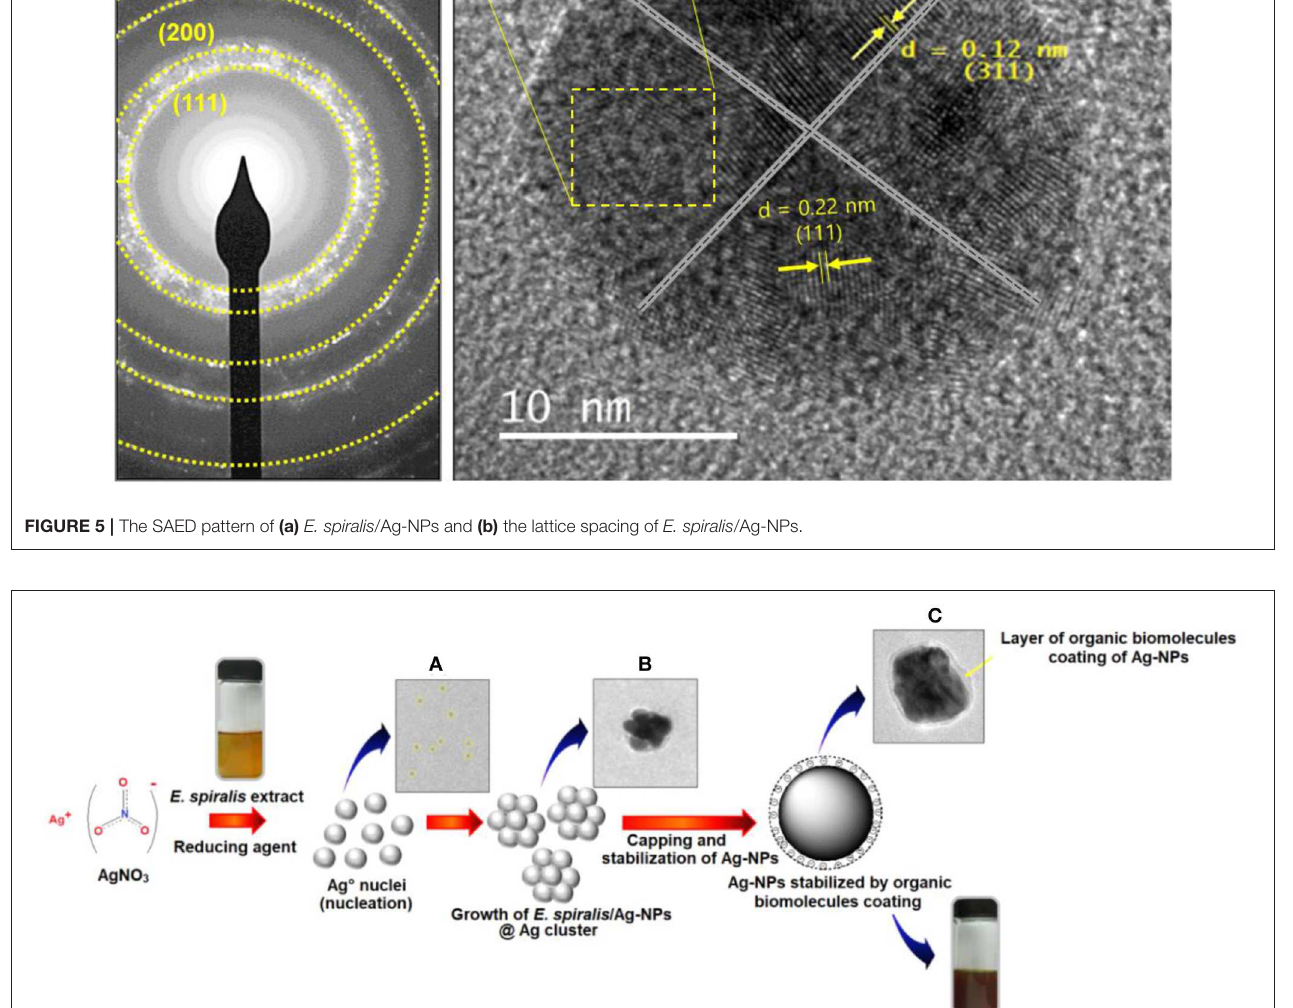
repulsive forces of electrostatic stabilization that can suppress Ag-NPs from aggregation (Banach and Pulit-Prociak, 2017). The the zeta potential analysis section. The micrograph image of Ag ◦ nuclei, growth E. spiralis /Ag-NPs, and E. spiralis /Ag-NPs, stabilized by biomolecules in the E. spiralis extract, are shown in Figures 6A–C ,